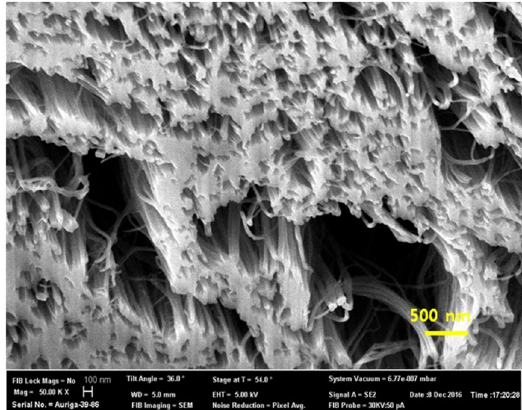
Figure 2. FIB images of the CNT yarn irradiated with 3.8 MeV beam energy, with dose rate of 5 kGy/sec at dose of 100 kGy 13 .